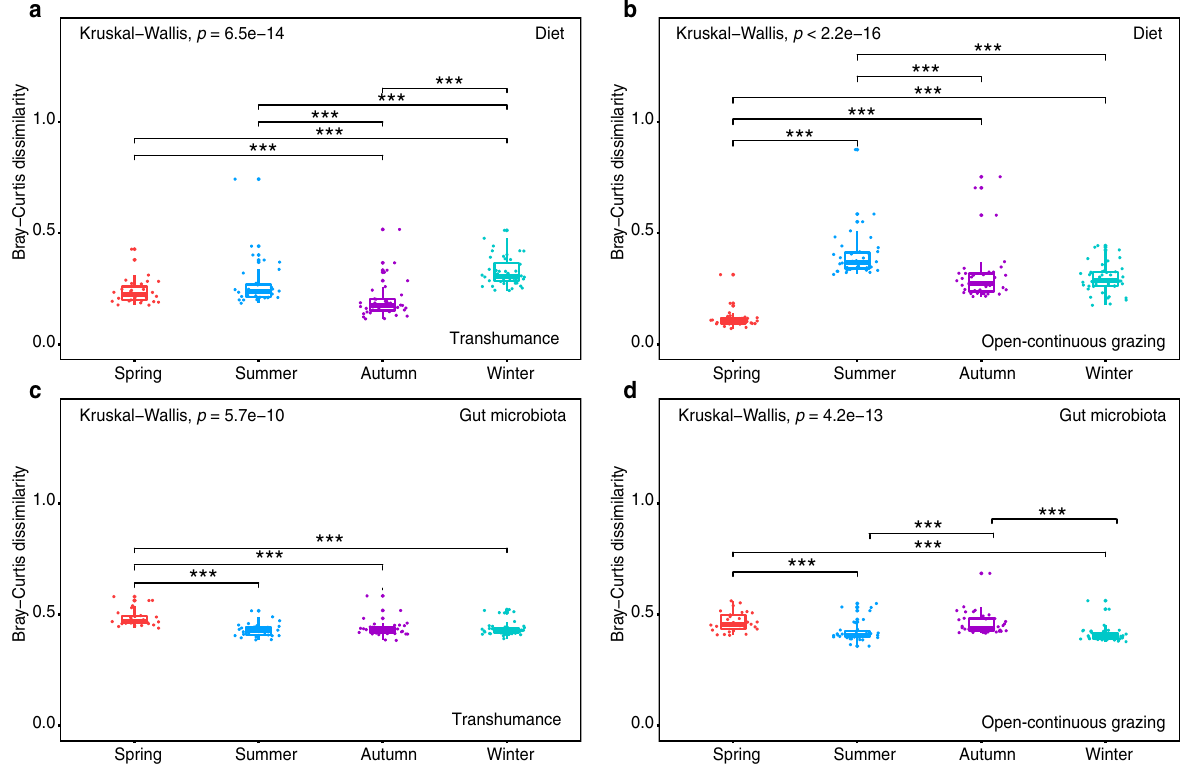
Fig. 6 Bray – Curtis dissimilarities within seasons in dietary diversity and gut microbial diversity across seasons in transhumance and open-continuous grazing regimes. Rows show the dissimilarities for diet ( a and b ) and gut microbiota ( c and d ) within seasons. Each column organizes the data so that diet and gut microbiota Bray – Curtis dissimilarities represent transhumance ( a , c ) and open-continuous grazing ( b , d ) regimes. All boxplot distributions are tested by non-parametric Kruskal – Wallis and Wilcoxon with FDR (false discovery rate) corrected p -value, center values indicate the median and error bars. * p < 0.05, ** p < 0.01, *** p <